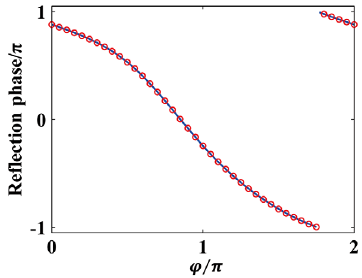
FIG. 8. The reflection phase as a function of the polar angle φ on a circle with radius 0.01 in the p - q space around the Weyl point. Blue solid line and red circles represent the reflection phases calculated through the transfer matrix method and Eq. (C14), respectively. Here, we consider the same Weyl point as in Fig. 6. The parameters of the PC are given by d a ¼ 97 nm, d 72 nm, and the Weyl point considered is between the first b ¼ and the second bands and located at ð p; q Þ ¼ ð 0 ; 0 Þ . The PC is truncated at the starting plane of the first layer, and the working frequency is also fixed at the frequency of the Weyl point, which is f w ¼ 247 . 6